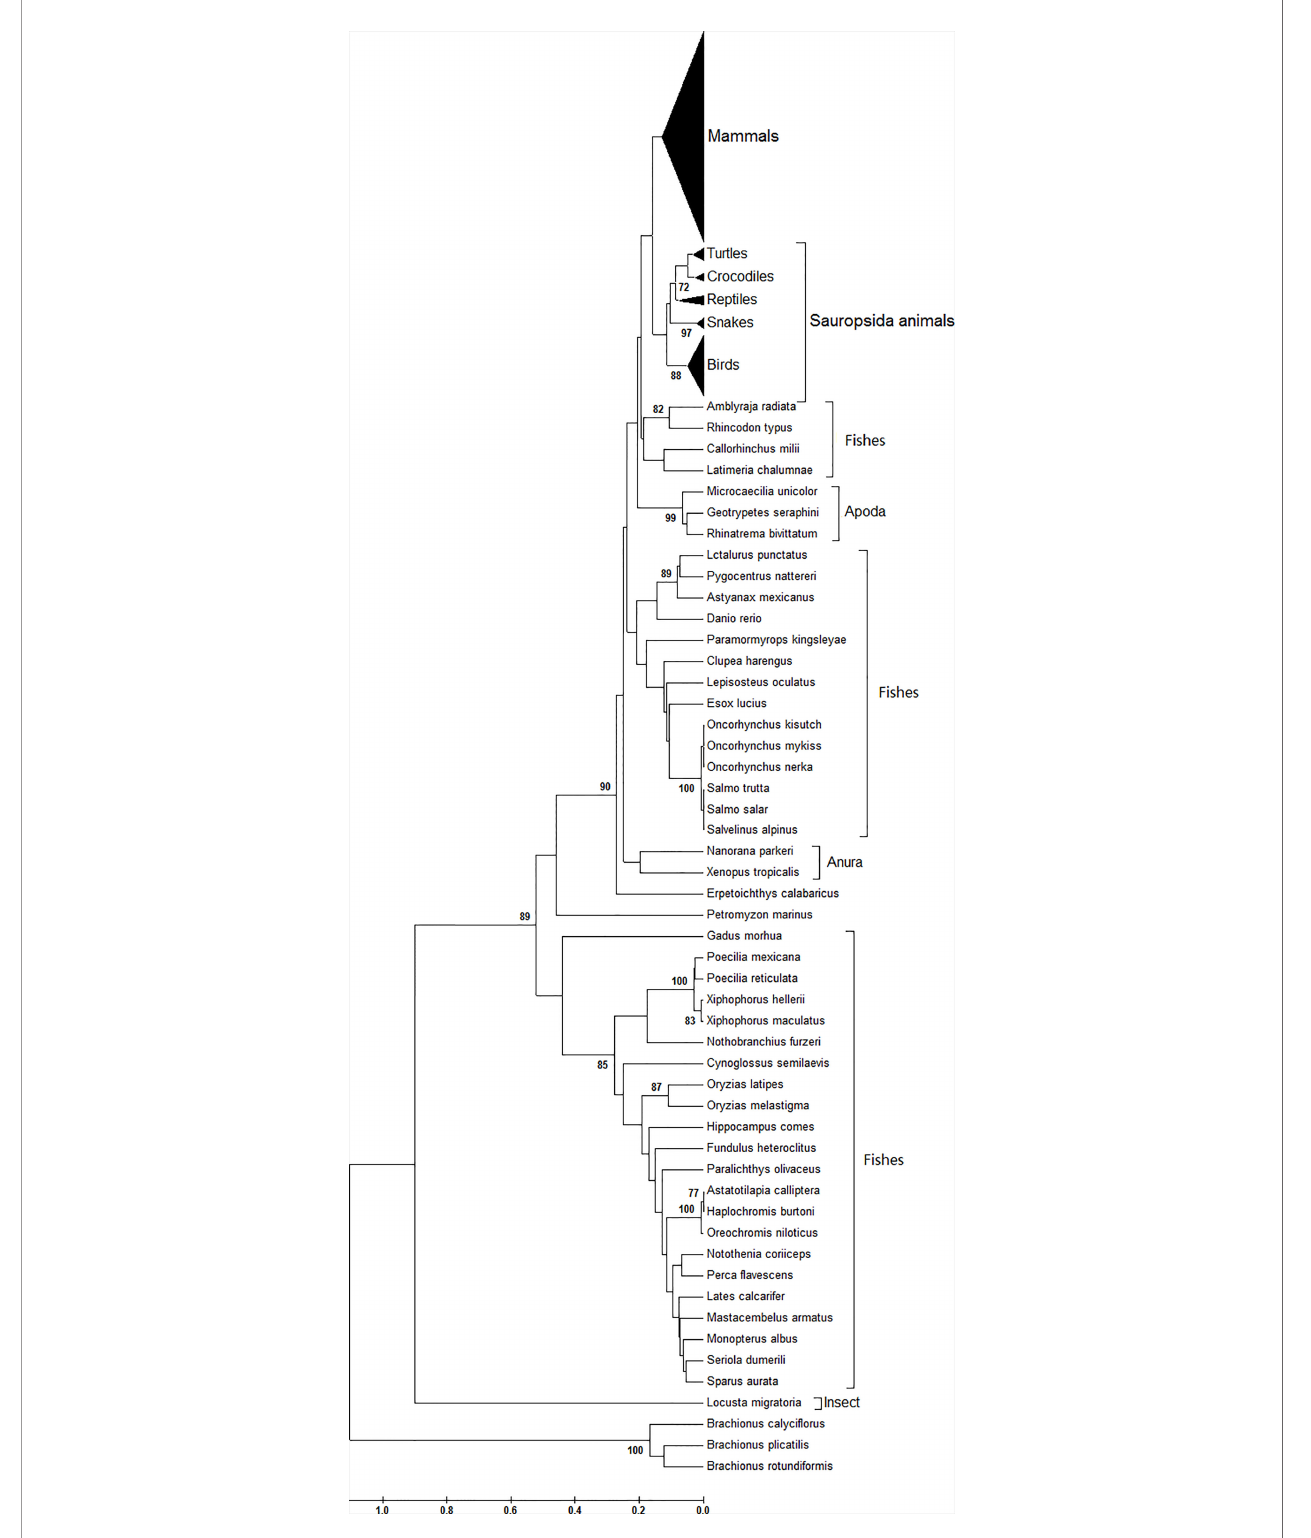
FIGURE 1 | Phylogenetic analysis of atg13 genes of 226 eukaryotic organisms. This phylogenetic tree was constructed by the Maximum Composite Likelihood model with UPGMA statistical method at the nucleotide level. Branches leading to these groups of sequences were supported by 100% of bootstrap replications in all cases.